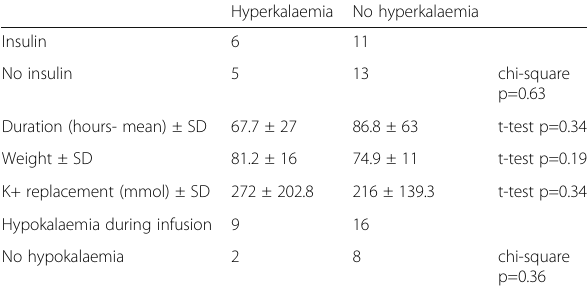
Table 46 (abstract A120). Hyperkalaemia following